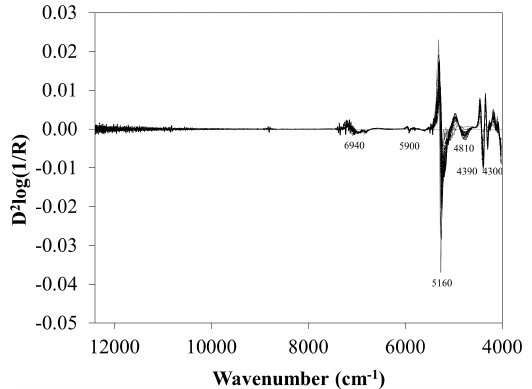
Fig. 3. Second derivative spectra of syrup.